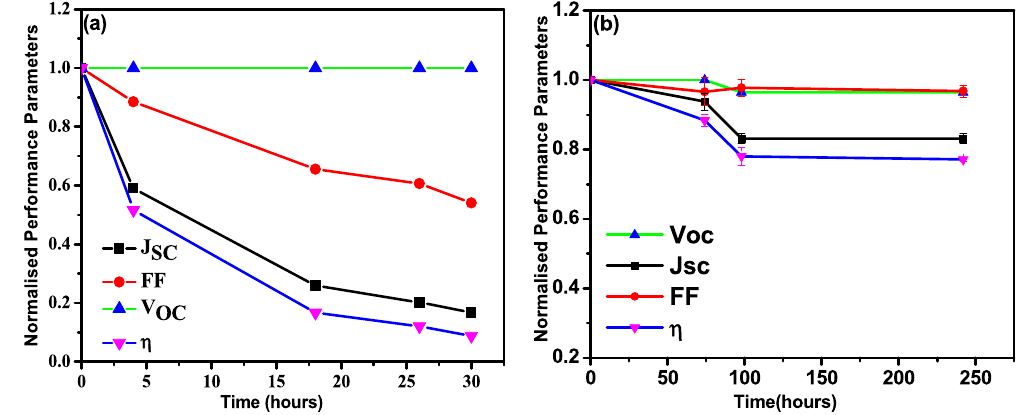
Figure 10. Stability of OPV devices with ( a ) PEDOT:PSS and ( b ) printed NiO as hole transport